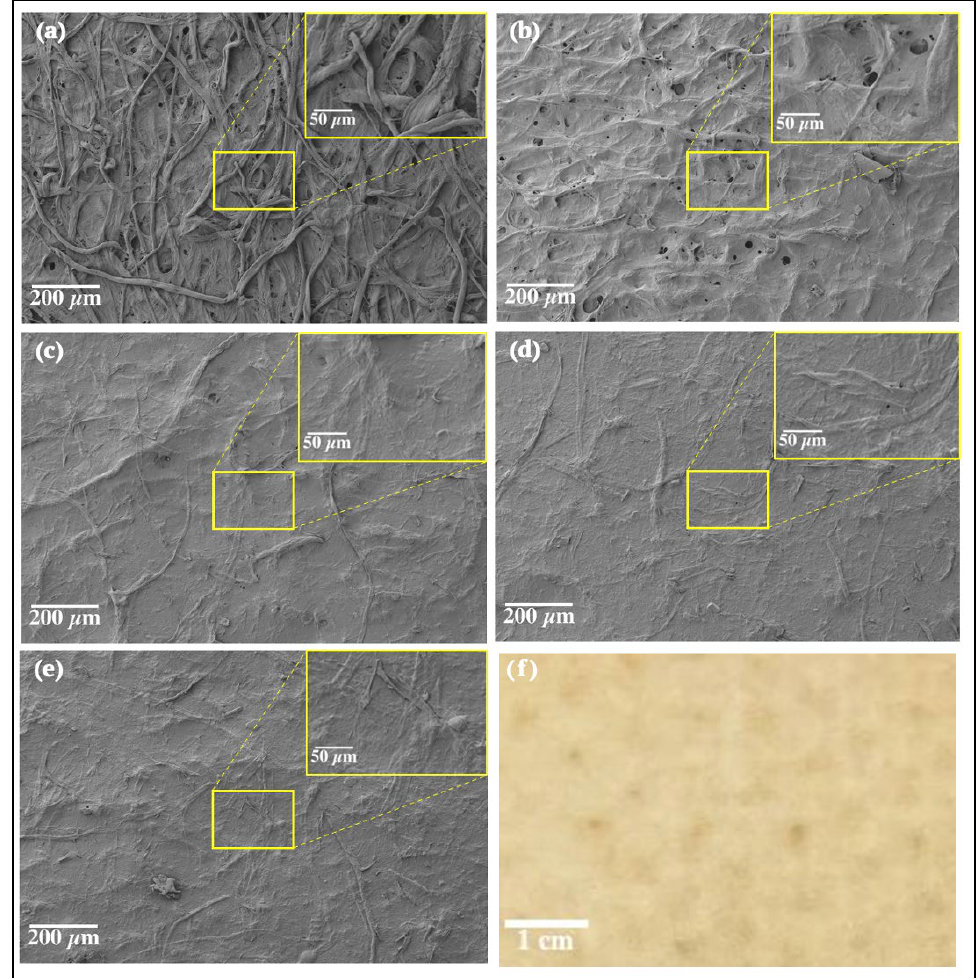
Figure 8. Surface SEM images of dry LCNF-modified filters at various coat weights: ( a ) uncoated control filter, ( b ) 3.11 gm − 2 , ( c ) 5.49 gm − 2 , ( d ) 6.02 gm − 2 , and ( e ) 9.54 gm − 2 at different magnifications (85× and 500×). ( f ) Magnified image of dry filter paper.